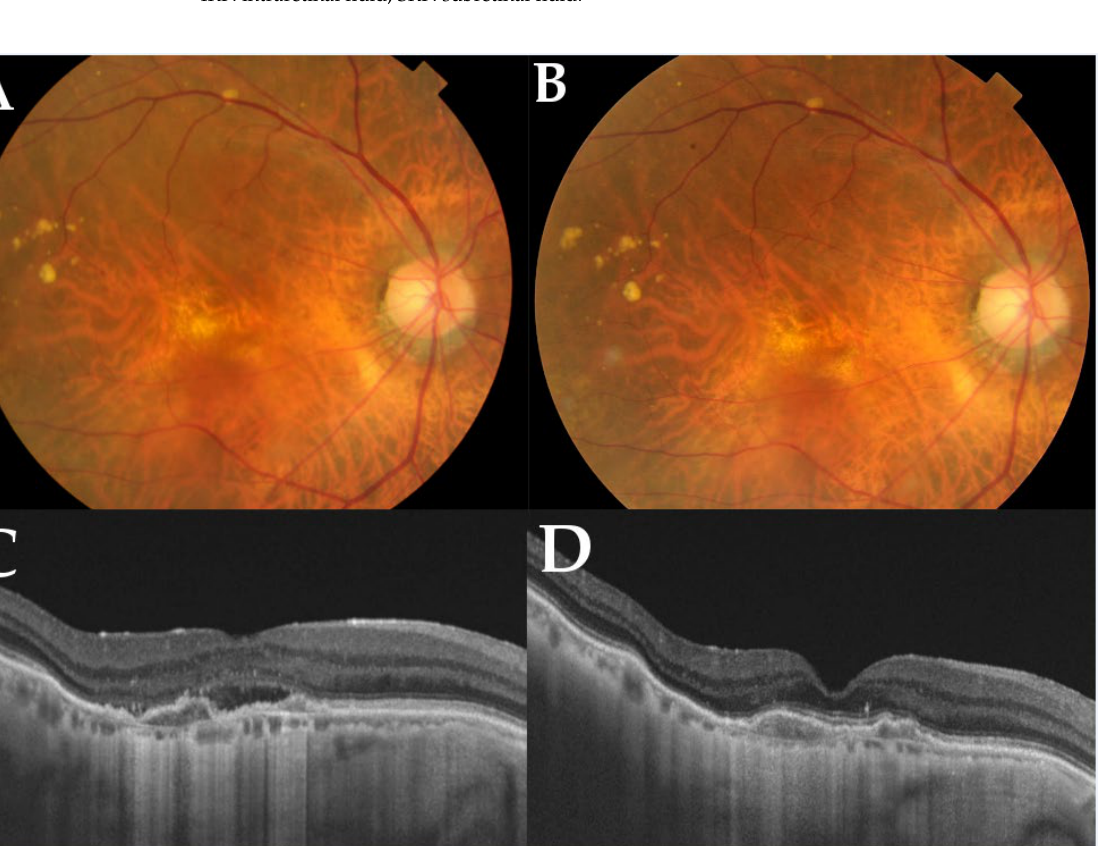
Figure 6. A representative case of an 82-year-old male with polypoidal choroidal vasculopathy in the right eye who switched to brolucizumab. Before switching, he had received a total of 50 injections during the follow-up period of 81 months. ( A ) At baseline, a color fundus photograph shows depigmentation at the juxtafoveal area. ( B ) At 12 months, a color fundus photograph shows no apparent changes compared with the baseline. ( C ) A horizontal OCT scan of the macula shows subretinal fluid and double-layer signs at baseline. After switching to brolucizumab, horizontal OCT scans of the macula at 12 months ( D ) show complete resolution of subretinal fluid accumulation. Best-corrected visual acuity in his right eye was improved from 0.15 logarithm of minimum angle resolution (logMAR) from the baseline to 0.10 loMAR at 12 months. The interval between the last aflibercept injection and the baseline was 5 weeks, which was extended to 8 weeks at 12 months.